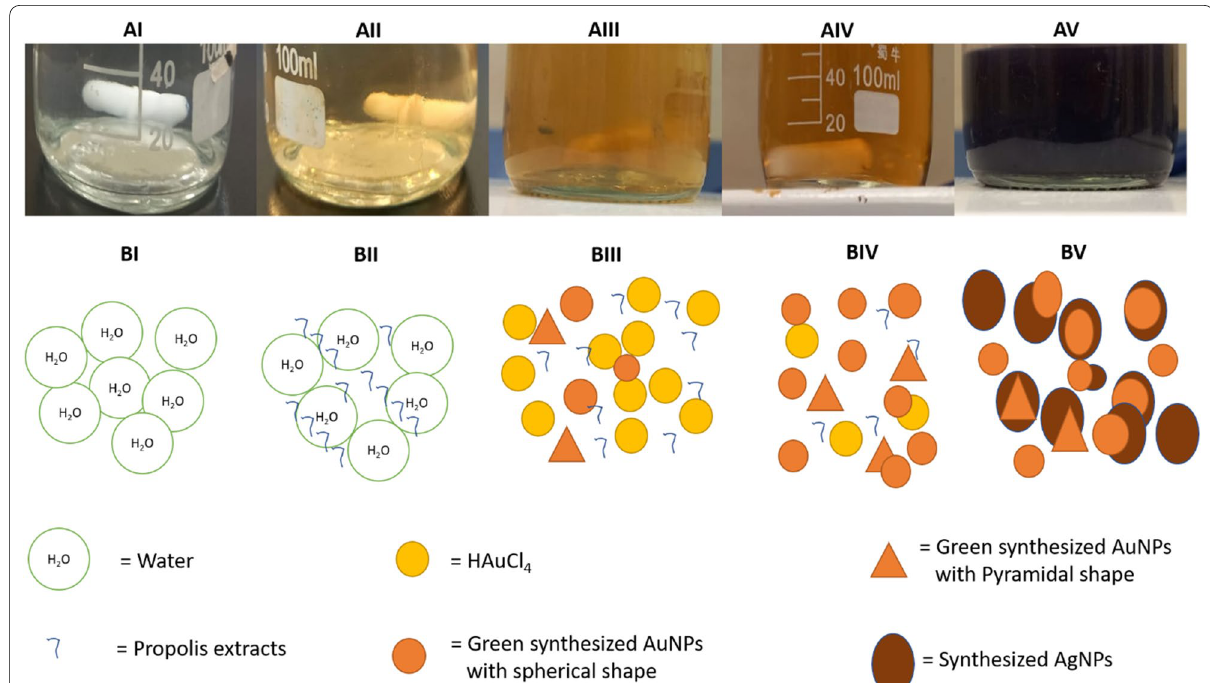
Fig. 1 Successive color changes during the synthesis of Au@AgNPs using ethanoic extract of propolis. AI and BI . The water is at zero point. AII and BII The water containing 3% propolis extract at zero point. AIII and BIII An intermediate step in forming the AuNPs after 80 min. AIV and BIV A late step in synthesizing the AuNPs after 120 min. AV and BV A final step in producing the Au@AgNPs, after 90 min of adding AgNO 3 to green synthesized